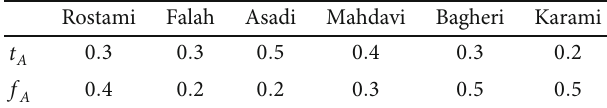
Table 3: The level of sta ff capability.